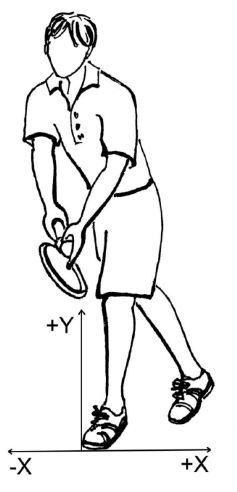
Figure 2. Orientation of global coordinate